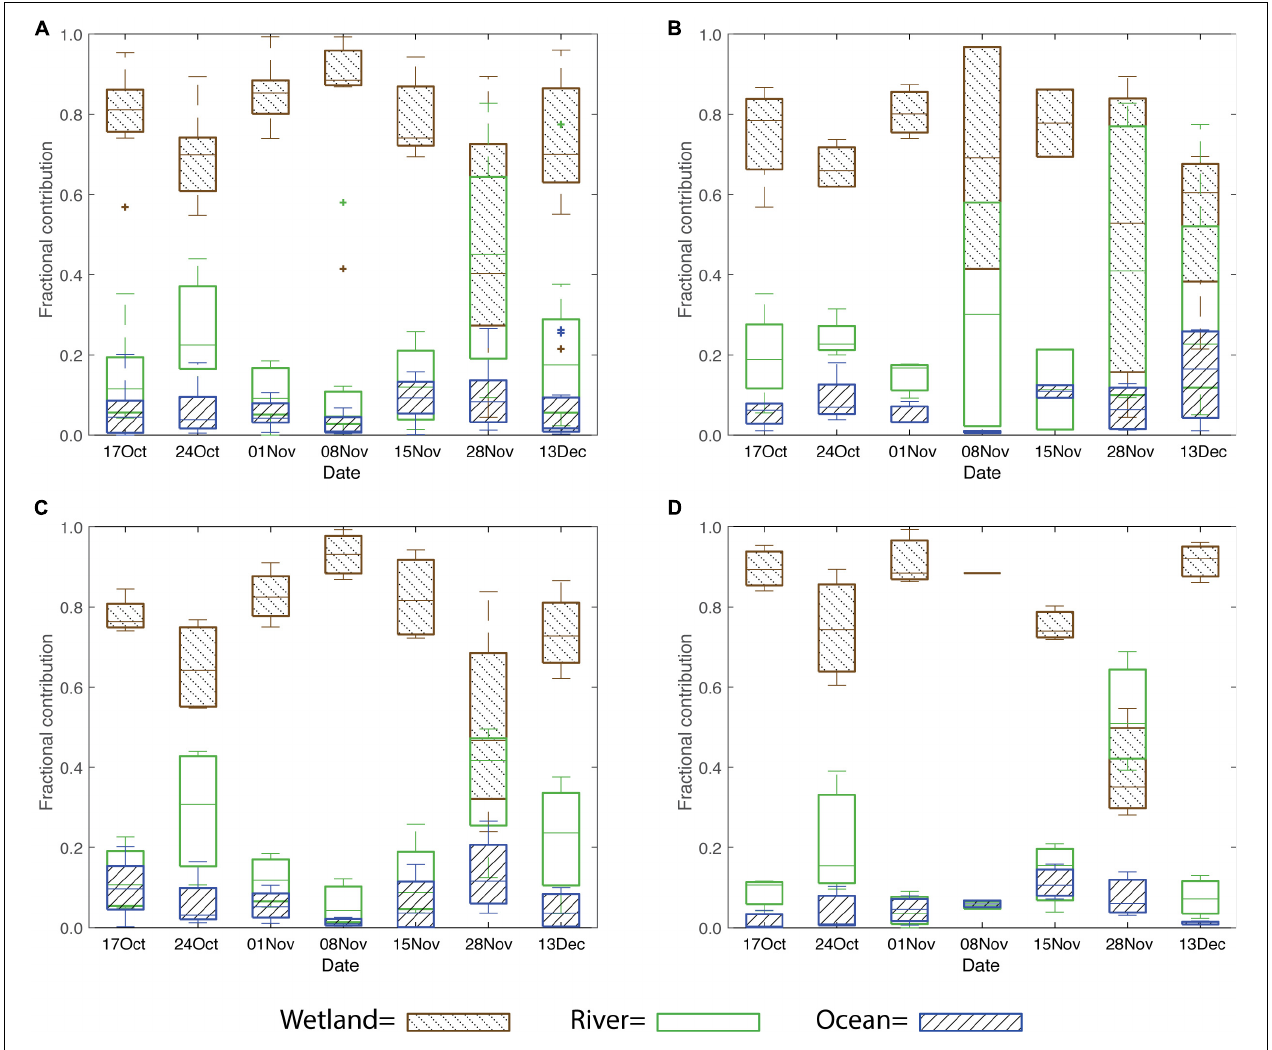
FIGURE 6 | Best fit calculated f w , f r and f s for (A) the entire NRE, (B) upper NRE, (C) middle NRE and (D) lower NRE in October through December 2016. On each boxplot: colored line is median, lower and upper extent of box refers to 25th and 75th percentiles, respectively, the whiskers on ends of box are range of samples, not considered outliers, and colored (+) are